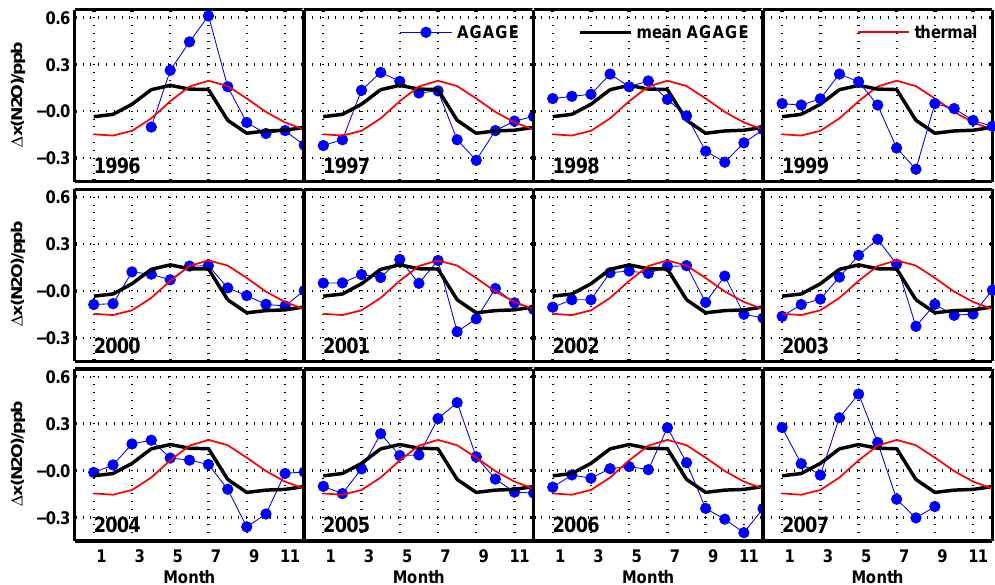
Fig. 2. Monthly mean detrended AGAGE N 2 O residuals at Trinidad Head, California. The “mean” annual cycle in observed N 2 O and estimated mean annual thermal N 2 O cycle associated with oceanic ingassing and outgassing are superimposed on each year’s observed